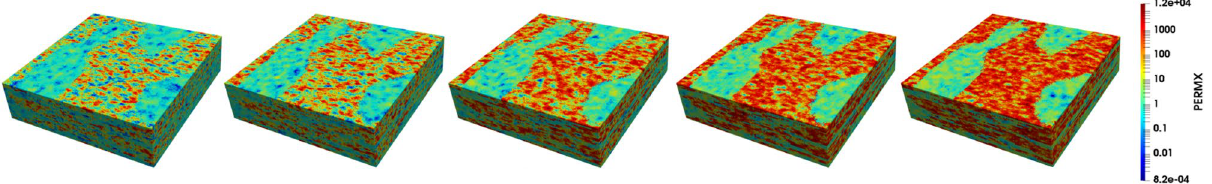
Figure 5. Realizations of permeability of the storage